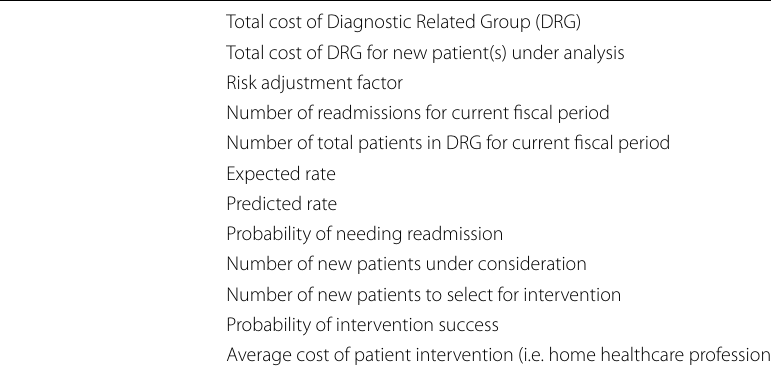
Table 2 Variable definitions in cost